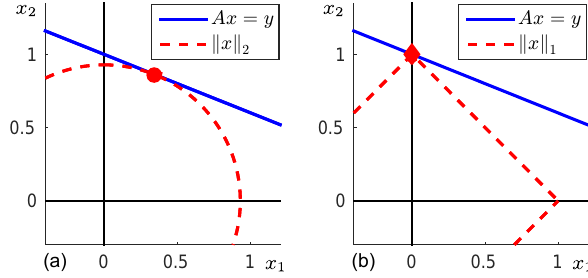
Figure 1. Illustration of 2-norm and 1-norm regularization for an underdetermined problem A x = y in R 2 . Generally, the minimum 1-norm solution (b) is zero in one of the two components. Such sparsity rarely happens when considering the minimum 2-norm so- lution (a) . Similarly, the minimum 1-norm solution produces solu- tions with as many zero components, as consistent with the data in higher-dimensional underdetermined